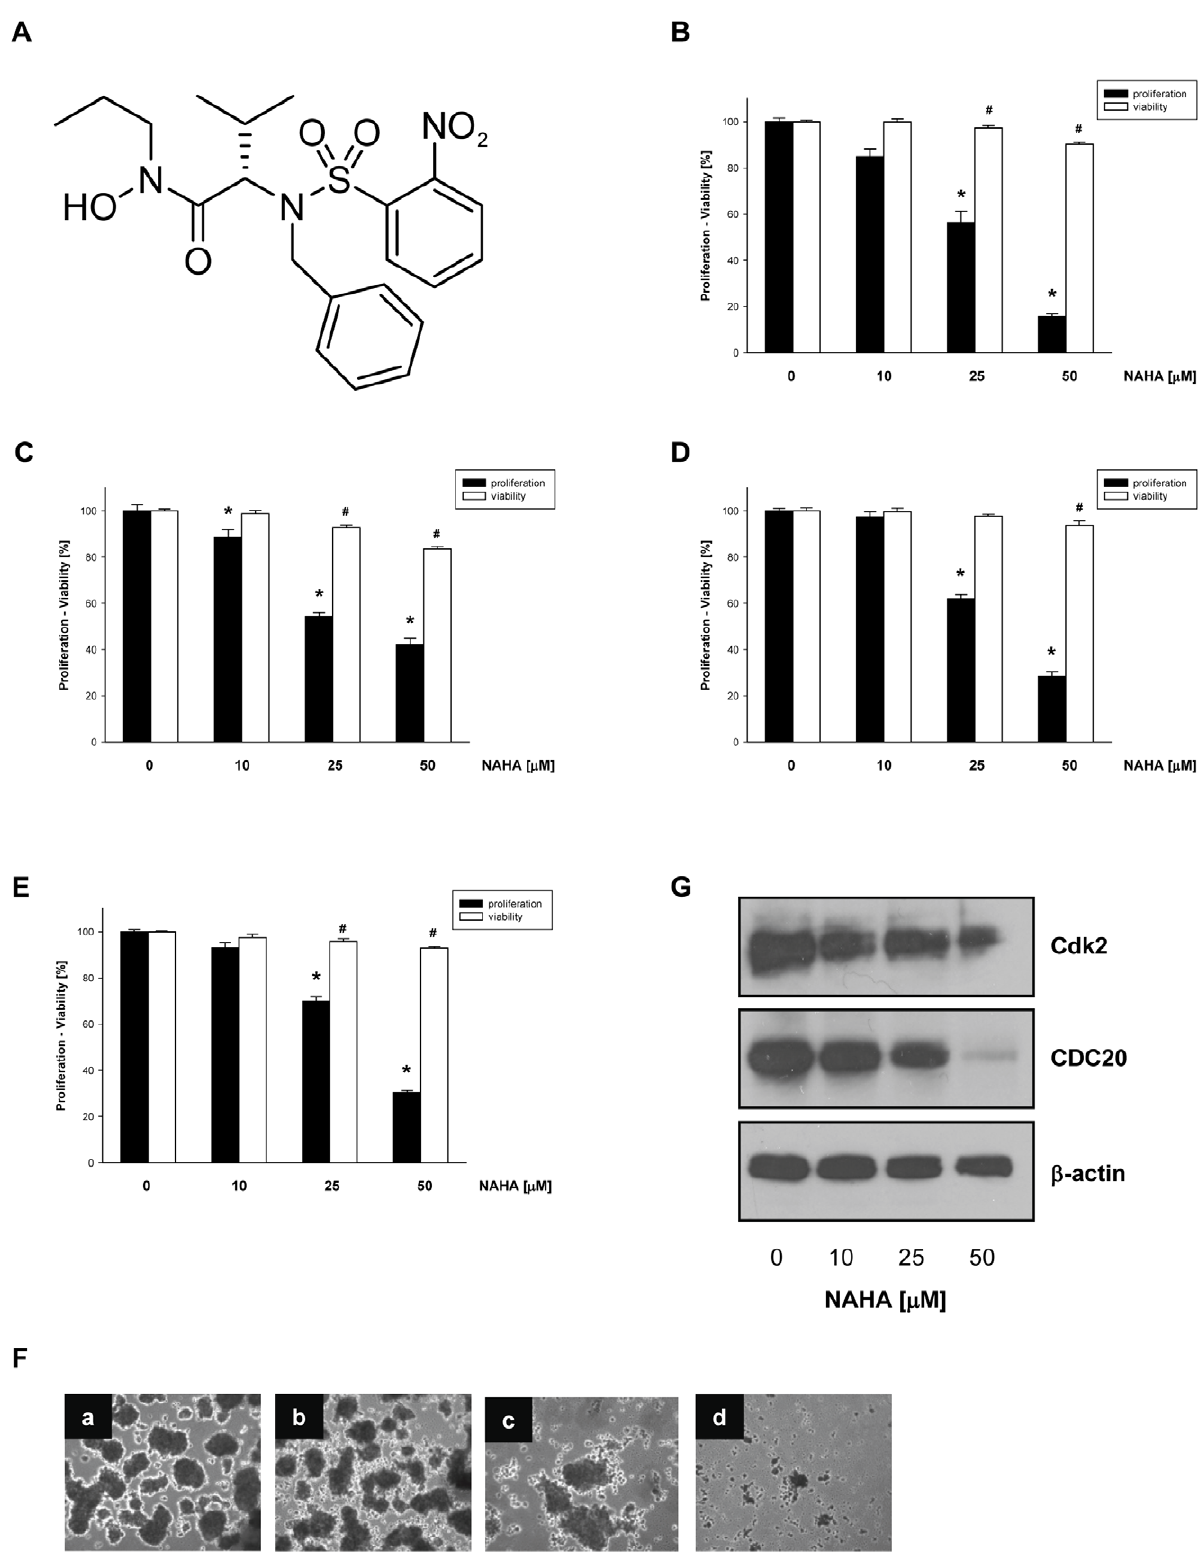
Figure 1. NAHA inhibits growth of breast cancer cells. (A) Structure of NAHA, 2-[Benzyl-(2-nitro-benzenesulfonyl)-amino]-N-hydroxy-3-methyl-N- propyl-butyramide . (B) MDA-MB-231, (C) MCF-7, (D) MCF-10A, (E) HMEC cells were treated with NAHA (0–50 m M). Cell proliferation was determined by the tetrazolium salt method as described in Materials and Methods . Cell viability was determined by trypan blue staining as described in Materials and Methods . Data are the means 6 SD. Similar results were obtained in at least two additional experiments. * p , 0.05 for cell proliferation, # p , 0.05 for cell viability. (F) Anchorage-independent growth (colony formation) of MDA-MB-231 cells was assessed on 1% agarose after incubation with NAHA (a